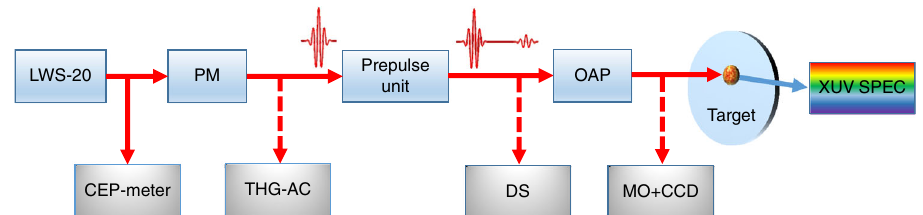
Fig. 1 Experimental set-up. LWS-20 delivers relativistic two-cycle laser pulses. A small portion of the beam is used in a stereo-ATI phasemeter to measure the CEP for every shot. The contrast of the main pulse is improved by 2.5 orders of magnitude by a plasma mirror (PM) and characterized by a third-order autocorrelator (THG-AC). A controllable prepulse is produced in the prepulse unit. Afterwards, the on-target pulse duration is measured and optimized with a home-made dazscope (DS) in combination with a Dazzler in the system. An off-axis parabolic mirror (OAP) tightly focuses the beam on the fused silica target that is translated after every shot. The generated XUV emission is re fl ected to a fl at- fi eld spectrometer where it is spatially separated from the fundamental beam. Focus quality is checked and optimized with the attenuated beam by replacing the target with a microscope objective (MO) and imaging it to a